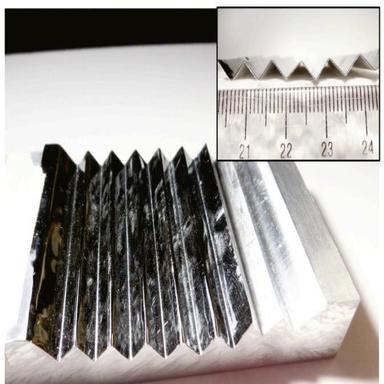
A two-layer sheet consisting of aluminized Mylar adhered to aluminum foil tape is shaped using the same 7-mm pitch grooved aluminum block as a die. This two-layer system readily conforms to the shape of the grooved mold, but substantial scratches can be seen on the delicate bare-metal side of the film.